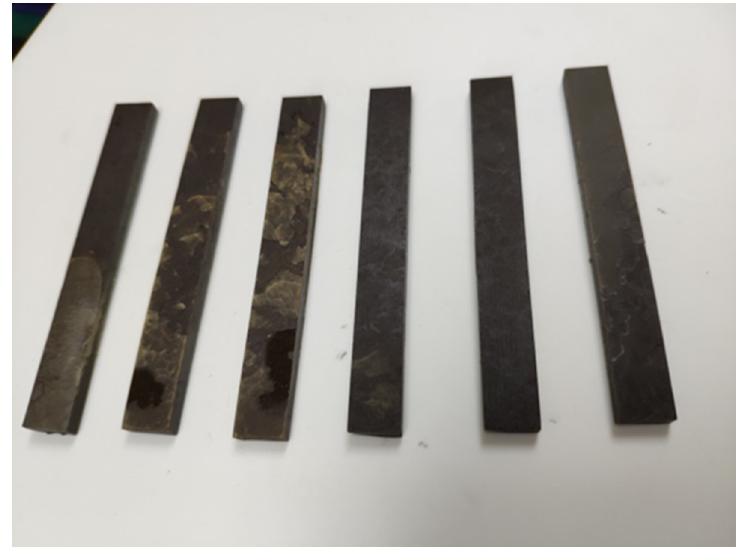
Figure 5. Epoxy mortar specimens after accelerated aging.